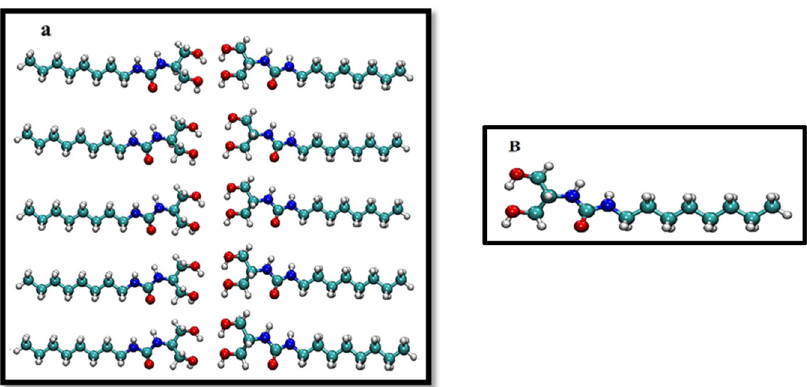
Fig. 1 The structure of OH channel. ( a ) The self-assembled OH channel, ( B ) the monomer of OH channel, color codes: O: red, N: blue, C: cyan, H: white.